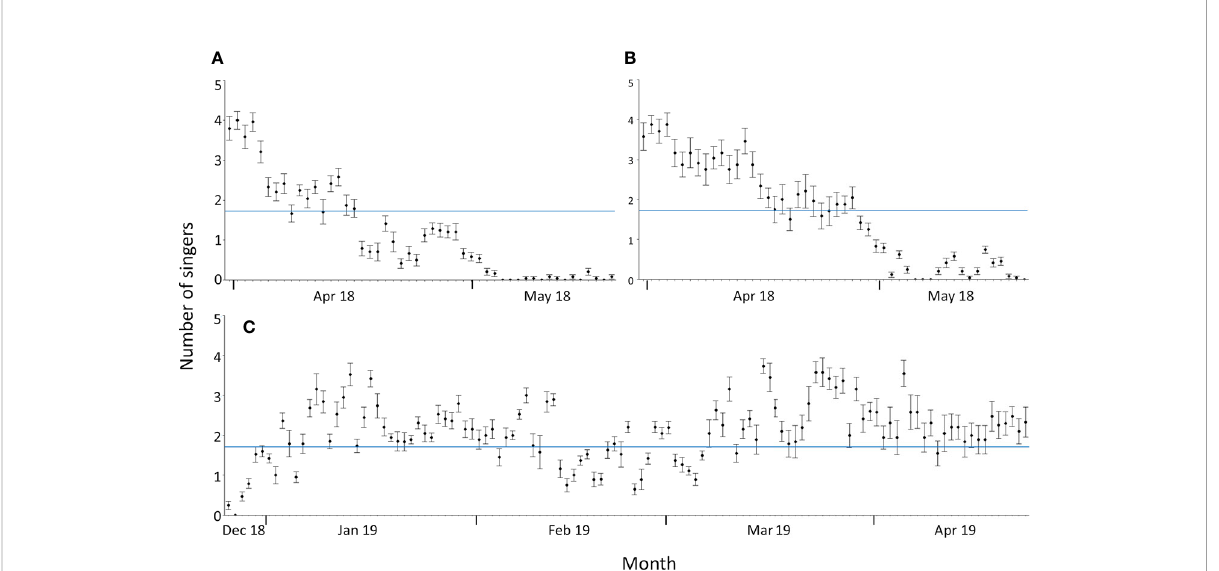
FIGURE 4 Daily mean number of singers during the whale season at Sally Tucker (A) and Challenger Bank between 31 March and 19 May 2018 (B) and between 26 December 2018 and 23 April 2019 (C) . Error bars are ± 1 standard error. The average number of singers across the entire whale season (1.73 singers; blue line) is illustrated as a